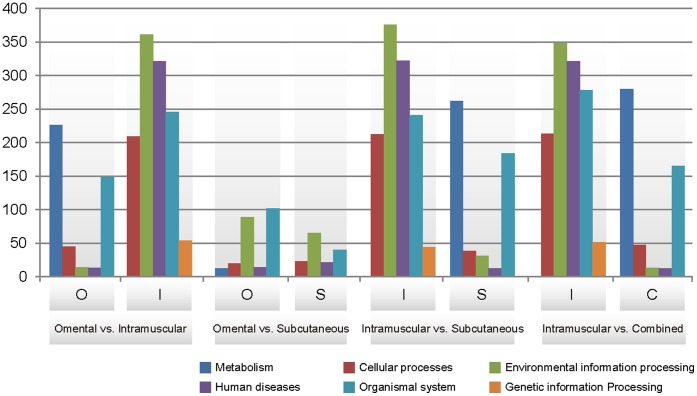
Representative KEGG pathways of DEGs resulted from the pairwise comparison among different adipose depots.Y-axis shows the number of gene counts.